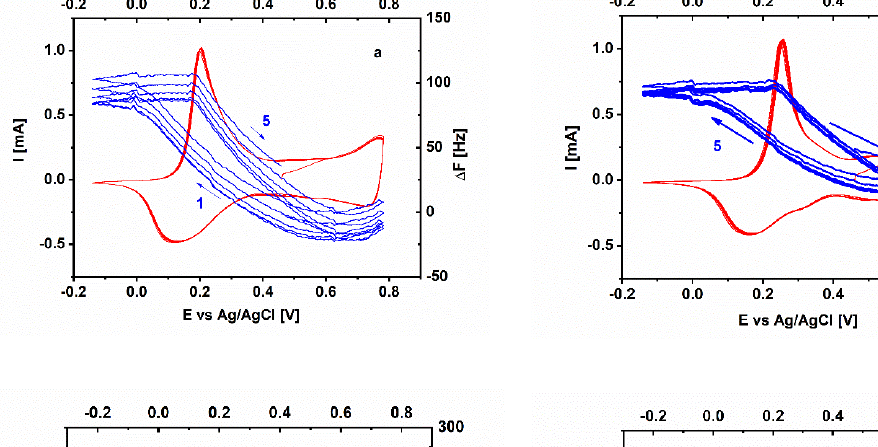
Figure 4. Frequency change in the course of electrochemical redox switching of thick PANI layers obtained in the presence of PAMPSA (black), t-PASA (blue), i-PASA (red) and PSSA (green): ( a ) as function of potential and ( b ) as function of oxidation charge.